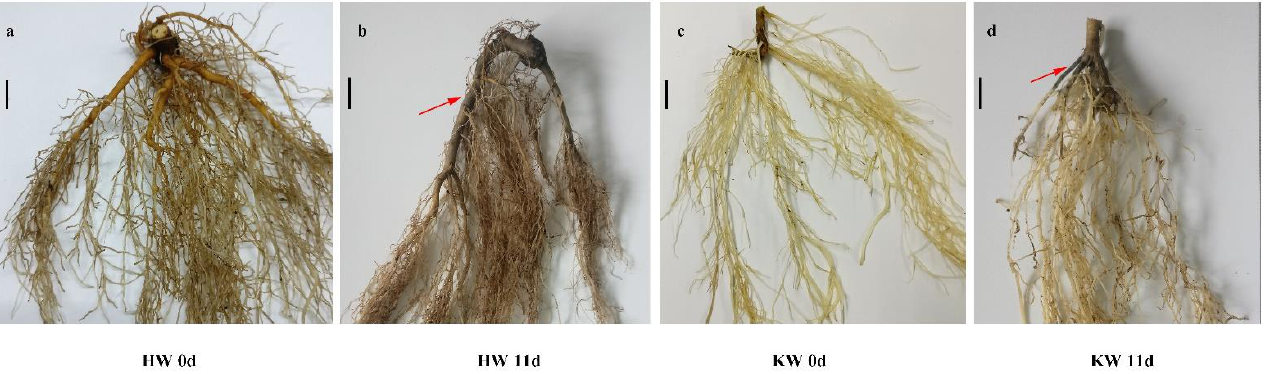
Figure 4. Morphological changes of roots of ( a , b ) ’Hayward’ and ( c , d ) KR5 under control and waterlogging conditions. HW 0d and HW 11d indicate ‘Hayward’ roots after 0 and 11 d of waterlogging stress, respectively. KW 0d and KW 11d indicate KR5 roots after 0 and 11 d of waterlogging stress, respectively. Arrows show the damaged root tissue, which turned black. Bar = 1 cm.